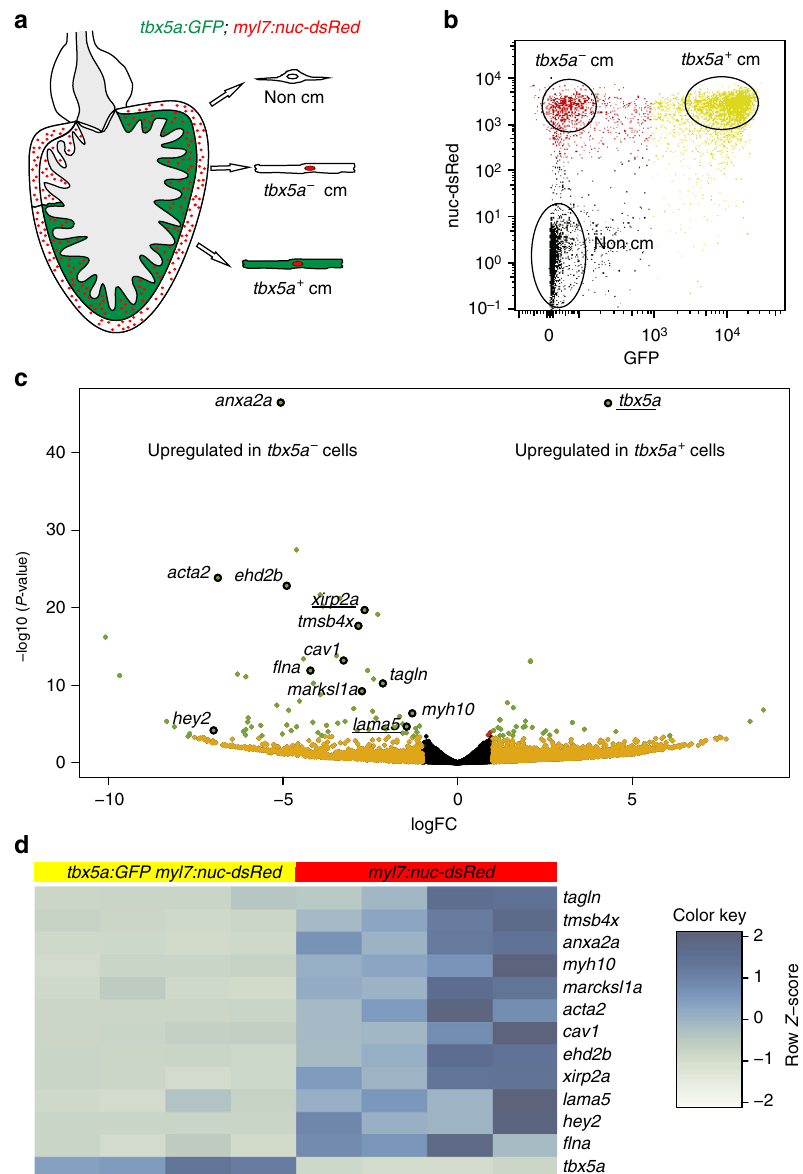
Fig. 7 tbx5a + and tbx5a − cardiomyocytes from adult ventricles exhibit distinct expression pro fi les. a , b GFP + /nuc-dsRed + and GFP − /nuc-dsRed + cardiomyocytes were fl uorescence-activated cell (FAC) sorted from adult tbx5a : GFP;myl7 : nuc-dsRed ventricles ( n = 5 pooled heart per replicate; four replicates in total). c Volcano plot representing RNA-seq results comparing both populations. Black, false discovery rate (FDR) > 0.05, log fold change (LFC) < 1; orange, FDR > 0.05, LFC > 1; red, FDR < 0.05, LFC < 1; green, FDR < 0.05, LFC > 1. d Heatmap of genes differentially expressed in tbx5a + and tbx5a – cardiomyocytes from adult hearts. Dark blue, higher expression; light blue, lower expression. cm,